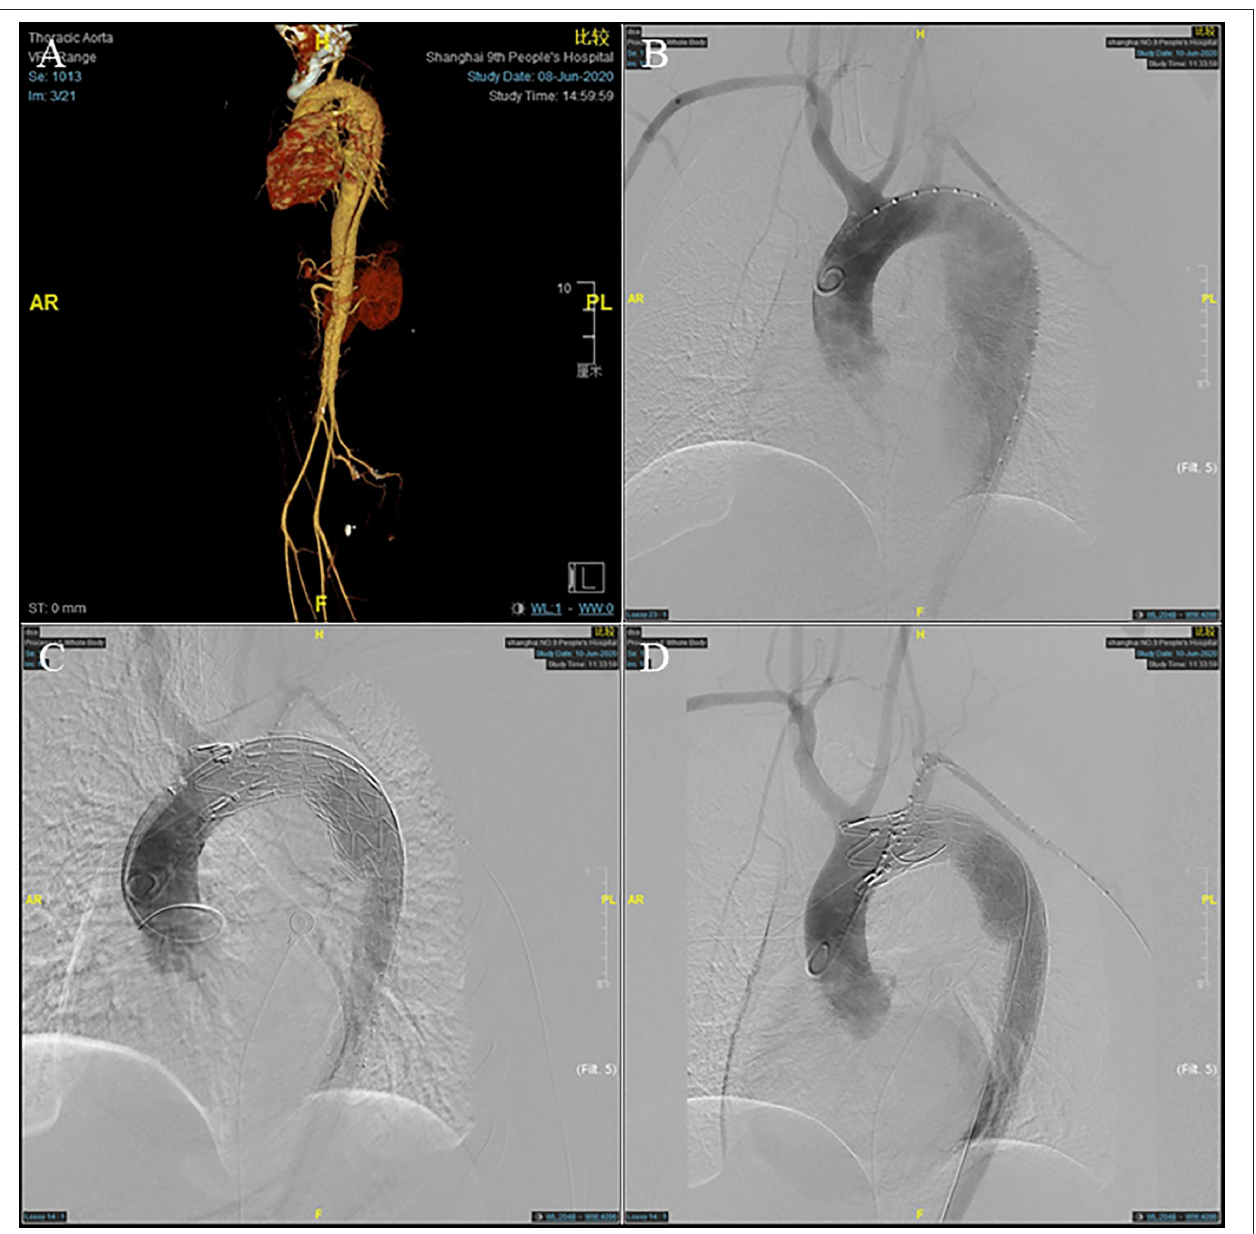
FIGURE 1 | A 45-year-old man who presented with 7 days of chest and back pain was diagnosed as type B aortic dissection (TBAD). (A) Pre-operative computed tomographic angiography (CTA) and (B) intra-operative angiography showed a pathologically changed aorta arch. (C) The stent graft was deployed to seal the aortic arch lesion, leaving its distal end partially within the restrictive covered stent (RCS). (D) After left subclavian artery (LSA) fenestration, post-operative angiography showing satisfactory repair of the dissected